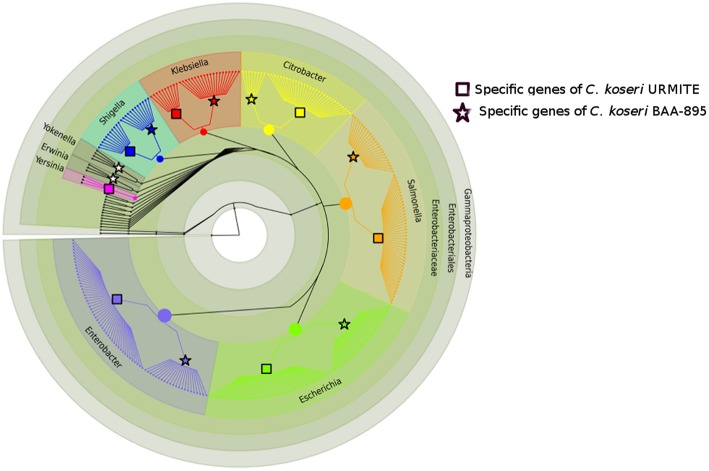
Phylogeny of strain-specific genes. The figure indicates the probable phylogenetic origin of the strain-specific genes at the genus level. The C. koseri URMITE and C. koseri ATCC BAA-895 specific genes are shown by square and star markers, respectively. The gene phylogeny with low branch supports or unresolved were not shown. The flow of gene exchange mainly involved Enterobacteriaceae spp.